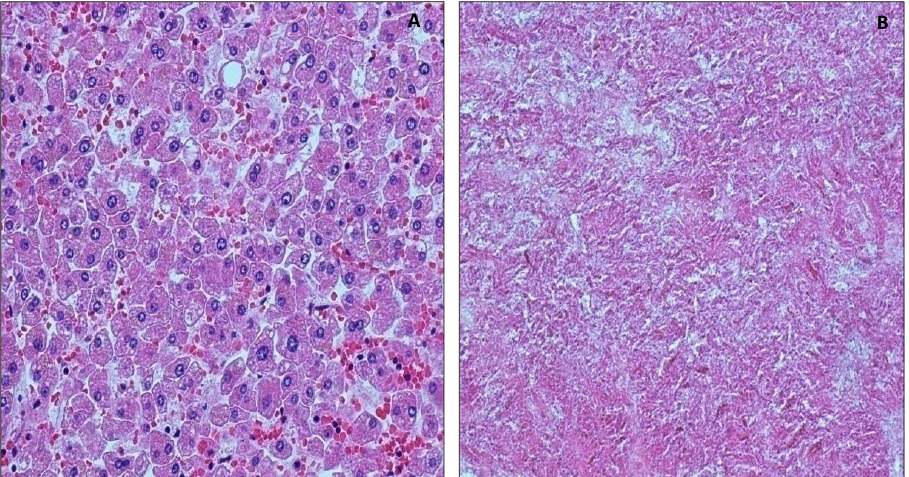
Figure 3. Morphological analysis of liver. ( A ) Image displays well preserved glomeruli and tubules 1 day after death, 20×. ( B ) Disgregated glomeruli and tubules 2 years after death, 10×.